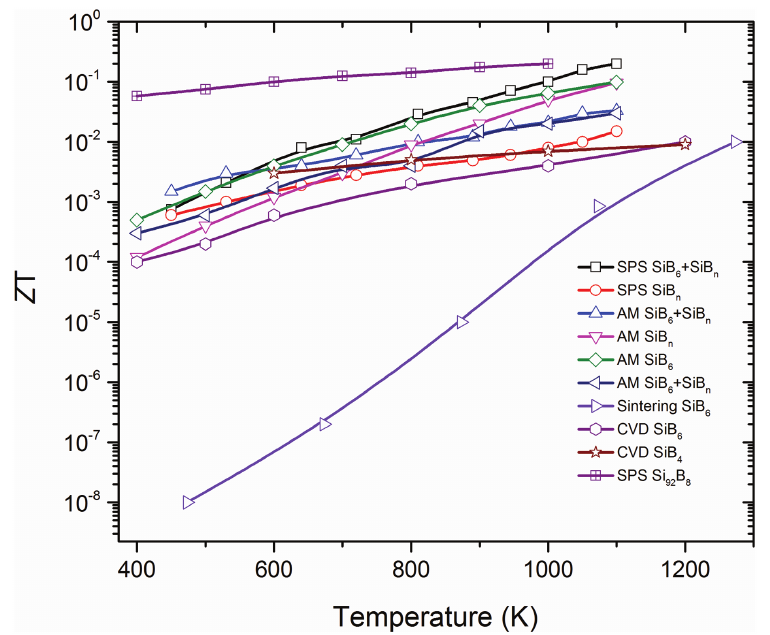
Figure 10: Effect of different processing method and temperature on ZT of silicon